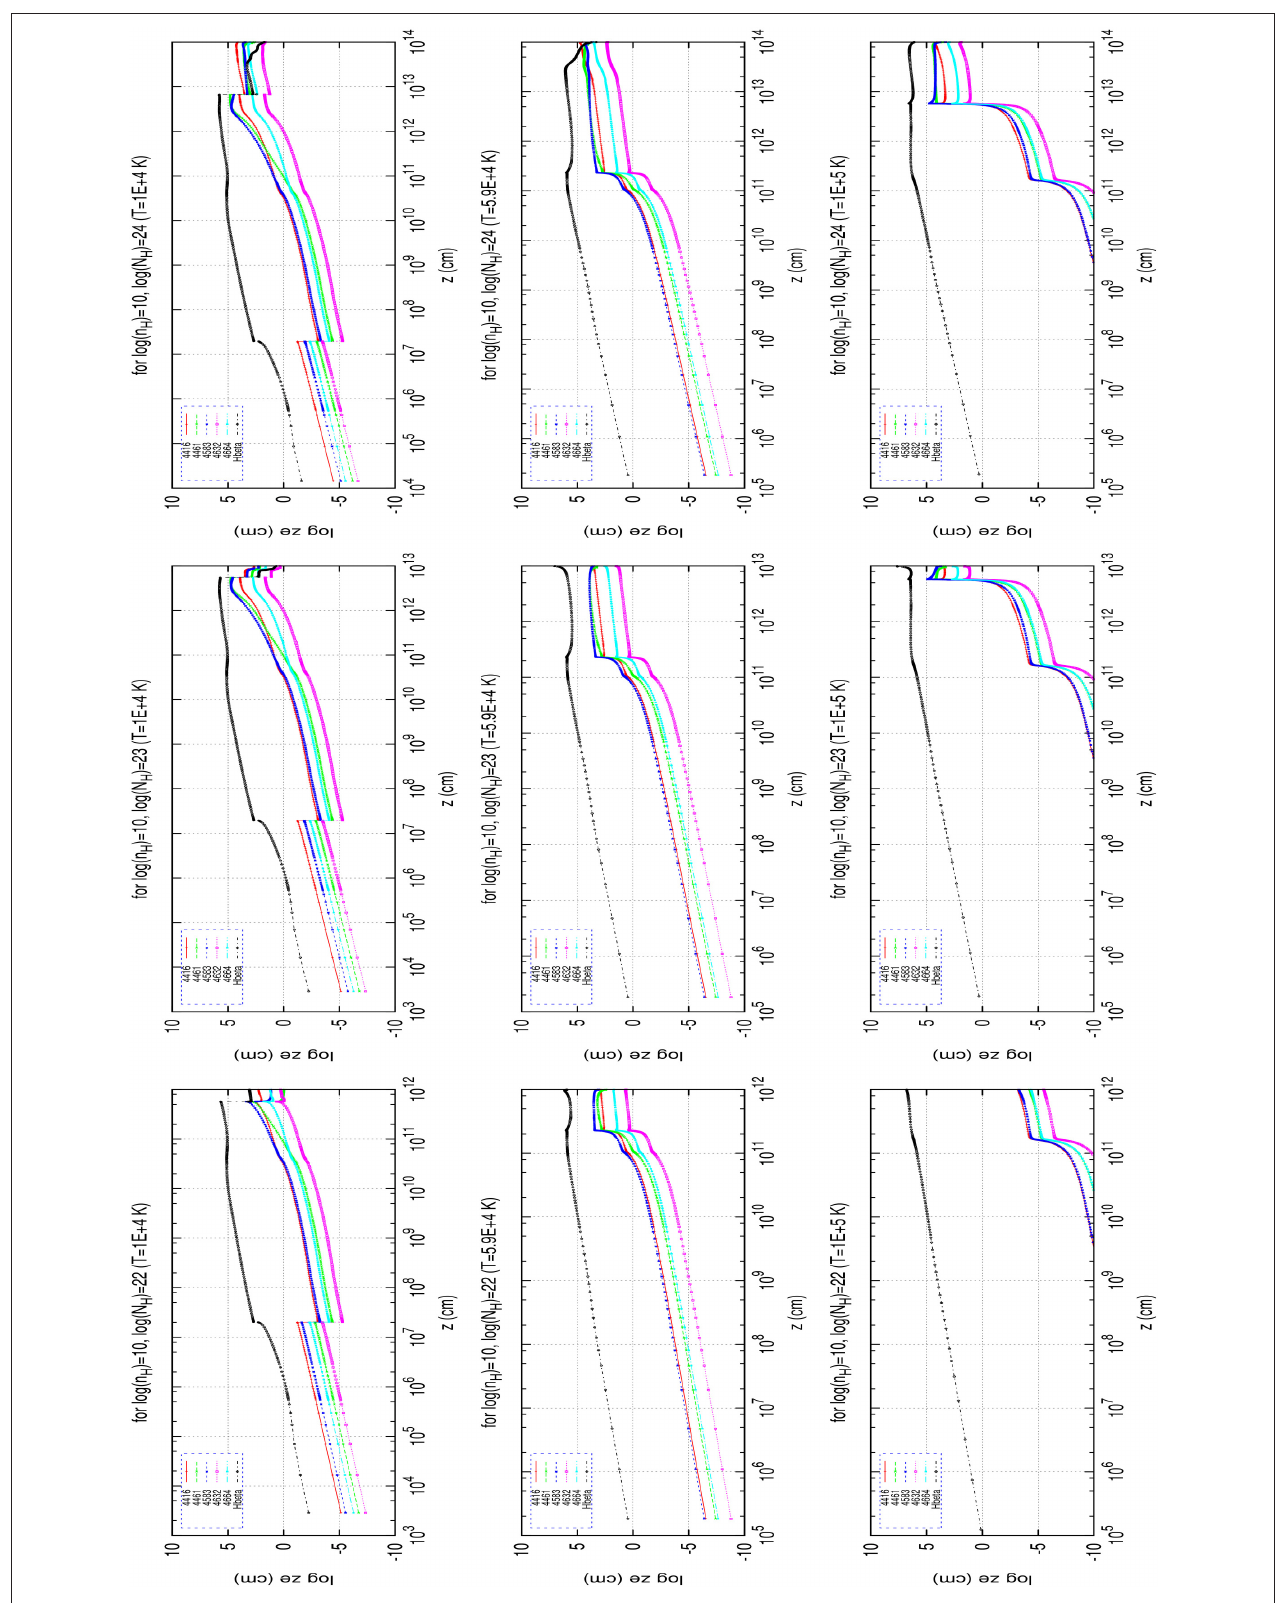
FIGURE 4 | Emissivity profiles of H β and FeII: comparison at three different T BBB values and column densities. X-axis label, geometrical depth (in cm); Y-axis label, geometrical depth (z) × emissivity (e).